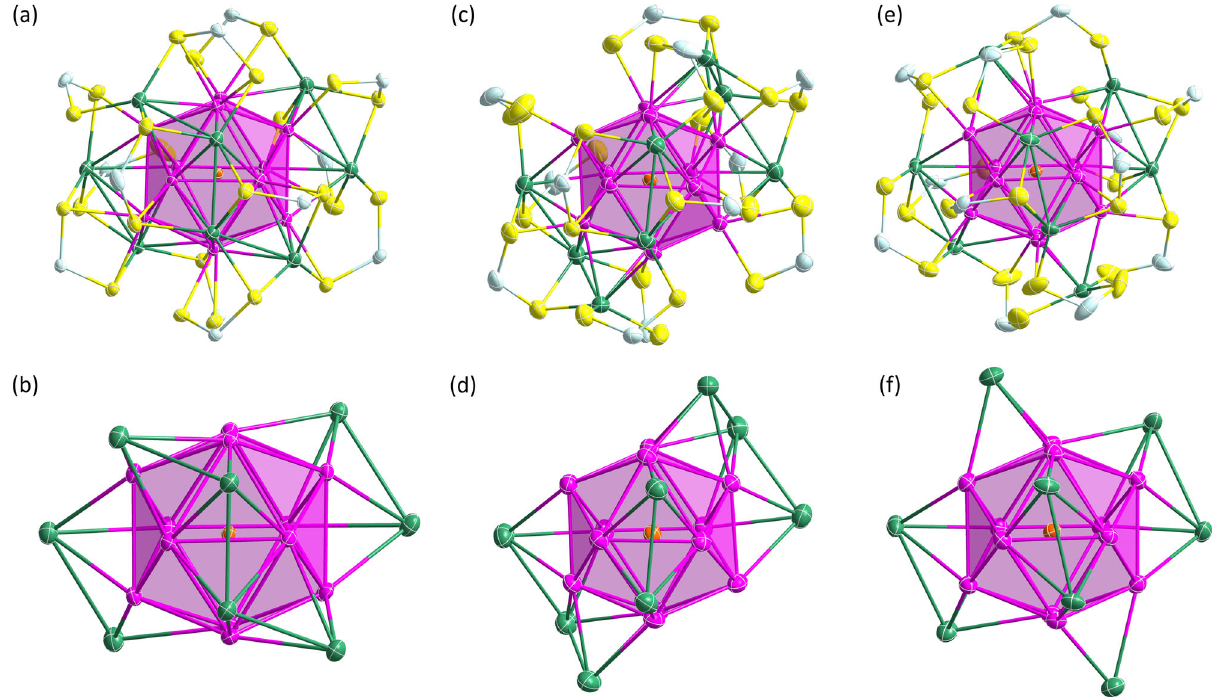
Fig. 3 Molecular structures of 1, 2a and 2b. a , b Total structure of 1 (propoxy groups omitted for clarity) and its Pd@Ag 20 metallic core with C 2 symmetry, respectively. c , d Total structure of 2a (isopropoxy groups omitted for clarity) and its Pd@Ag 20 metallic core with C 2 symmetry, respectively 36 . e , f Total structure of 2c (isobutoxy groups omitted for clarity) and its Pd@Ag 20 metallic core with D 3 symmetry, respectively. (color code. Pd: orange; Ag ico : pink, Ag cap : green; S: yellow; P: sky blue).